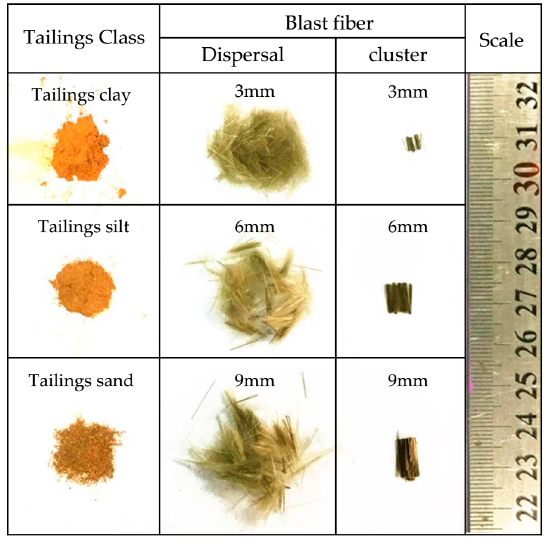
Figure 1. Basalt fibers and tailings particles. Table 1. Technical specifications of the basalt fibers [37].